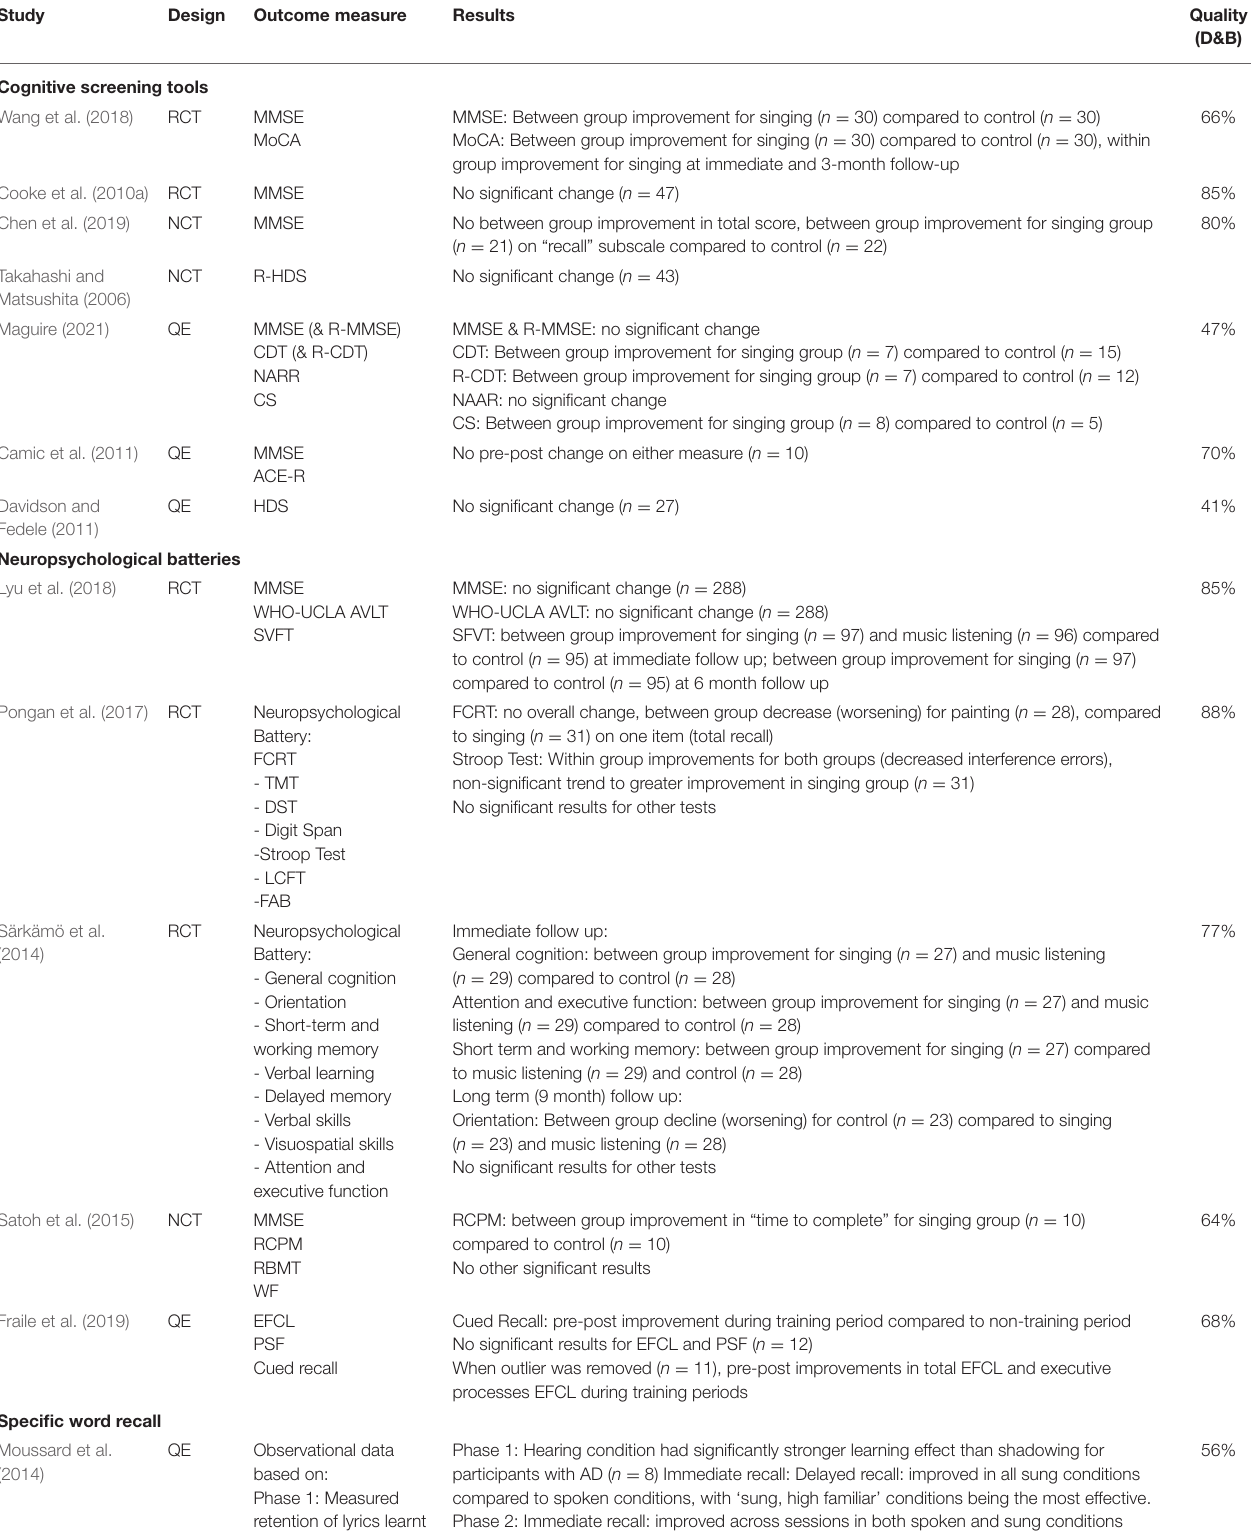
TABLE 5 | Overview of results for cognitive outcomes.